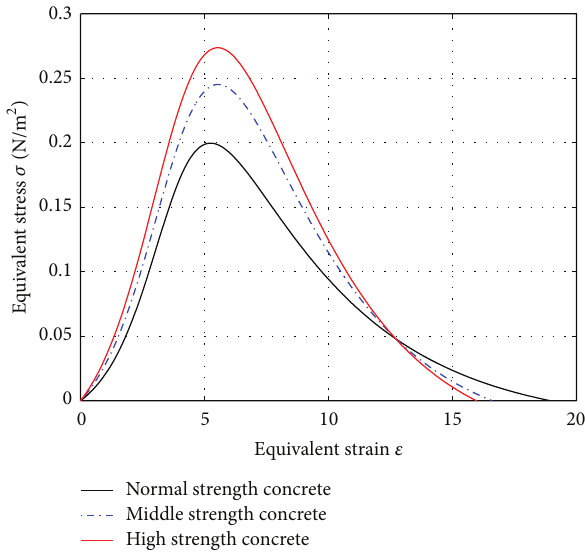
Figure 4: Concrete constitutive curves for different results.